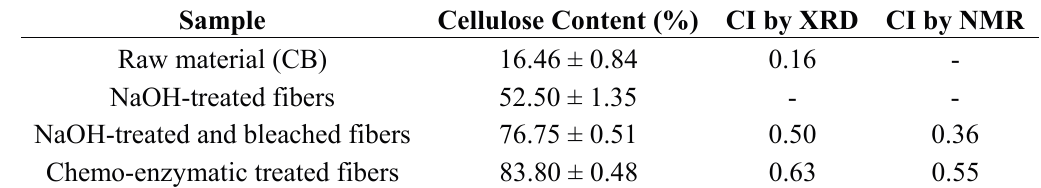
Table 1. Percentage of cellulose and crystallinity indexes (CI) calculated for the cellulosic materials using XRD and NMR